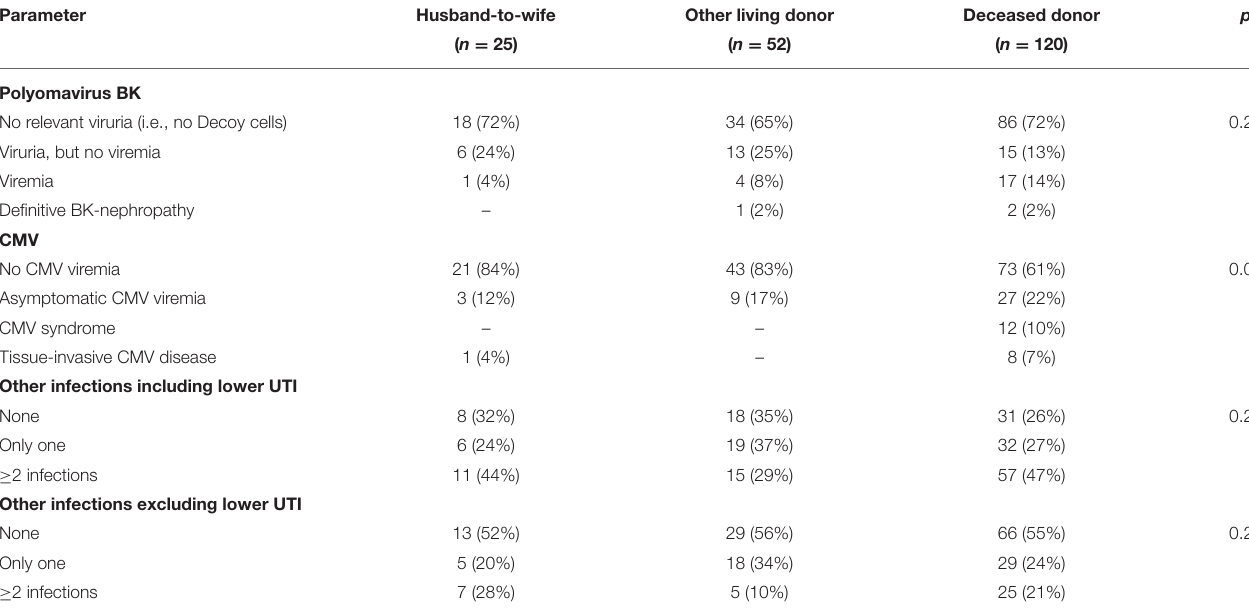
TABLE 3 | Infections occurring within the first year post-transplant. Parameter